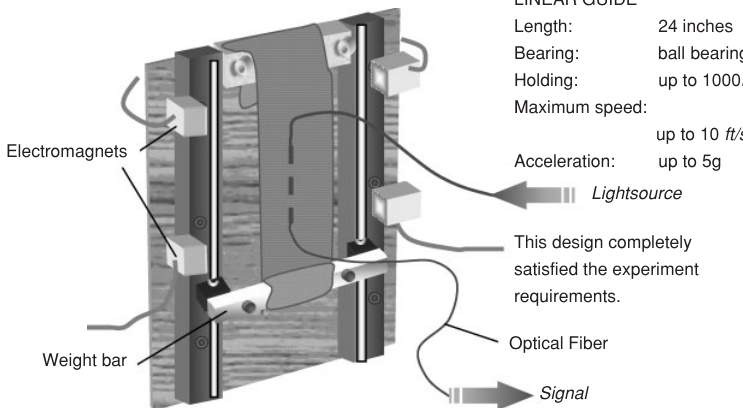
Figure 12 Experimental set-up designed for free-falling drop tests.